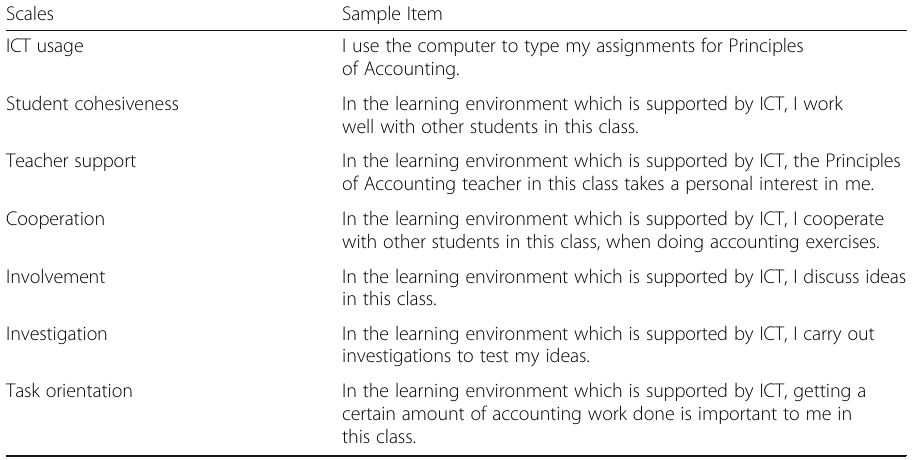
Table 2 Structure and sample items in the adapted TROFLEI instrument